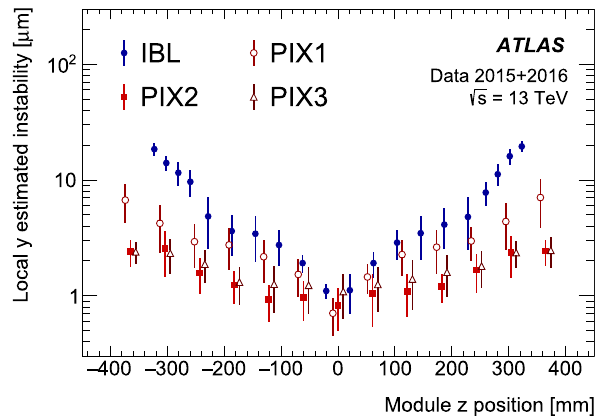
Fig. 14 Estimated σ time y as a function of the module global- z position for Pixel barrel layers. The vertical bar on each marker represents the standard deviation of the estimated value over modules at the same z - positionalongdifferentstaves.Theglobal- z positionisslightlymodified for the different Pixel layers for visualisation purposes